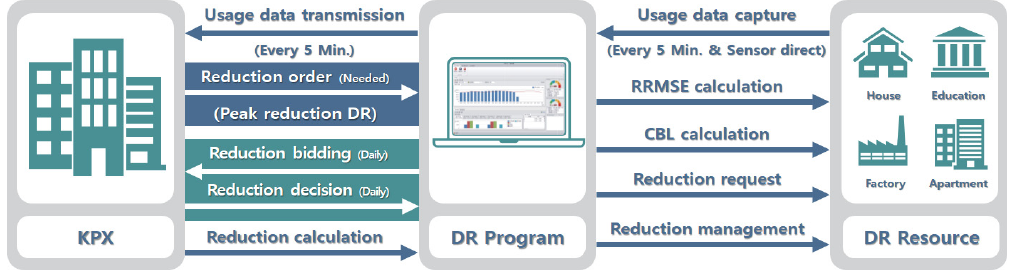
Figure 2. The structure of a demand-side management solution.